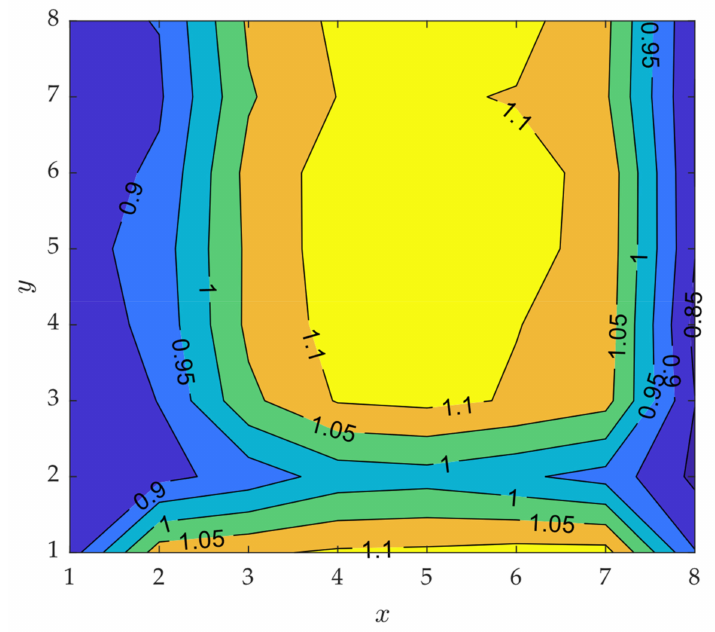
Figure 7. Spatial distribution of irradiance: the local irradiance E (cid:48) is compared to the mean irradiance E m of the 8 cm × 8 cm test plane under a representative LED cluster at 64 equidistant points; the diagram shows a contour plot, indicating zones where the ratio R = E (cid:48) /E m lies between the given limits; the axes of the plot indicate the dimensionless location of the measurement points; the 8 cm × 8 cm area was divided into 64 equidistant squares; the intensity measurements were made at the center of each